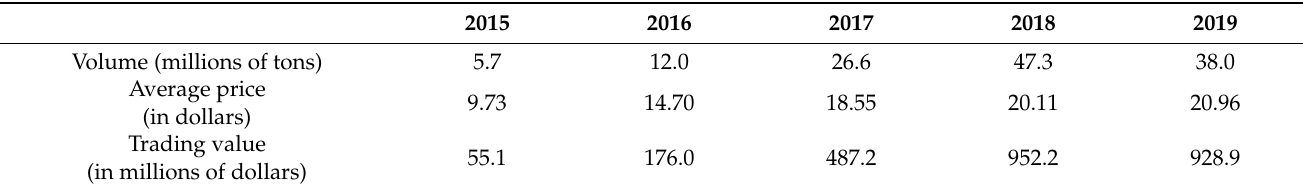
Table 4. The trends of the South Korean emission trading market (adapted from Korean emission trading system report.)